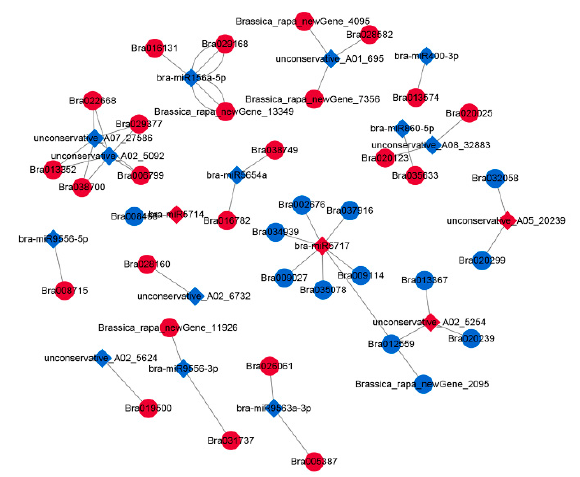
Figure 9. The view of DEmiRNA–DEmRNA network involved in anther development in Bcajh97-01B (fertile line) and Bcpol97-05A (sterile line) of Brassica campestris . The network includes 18 miRNAs and 37 mRNAs. miRNA and mRNA are indicated as diamonds and ellipses, respectively. The red color represents the up-regulated expression and the blue color represents the down-regulated expression.